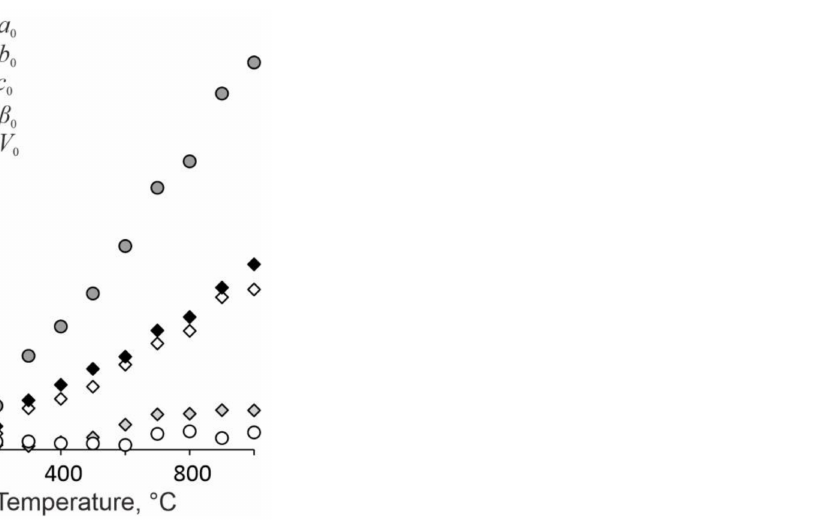
Figure 5. Evolution of normalized unit-cell parameters ( a / a 0 , b / b 0 , c / c 0 , β / β 0 ; V / V 0 , where a , b , c , β , V are the unit cell parameters at each temperature and a 0 , b 0 , c 0 , β 0 , V 0 are the unit cell parameters at room temperature) of